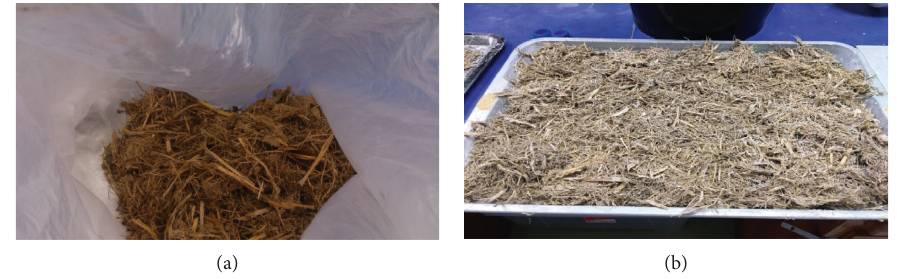
Figure 2: Adsorbents: (a) bagasse and (b) modified bagasse.